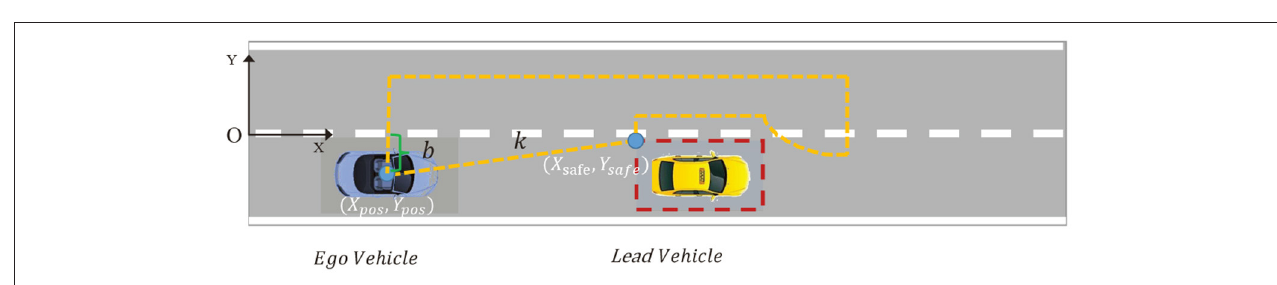
FIGURE 3 | Schematic of accessible driving area in the case of left overtaking.